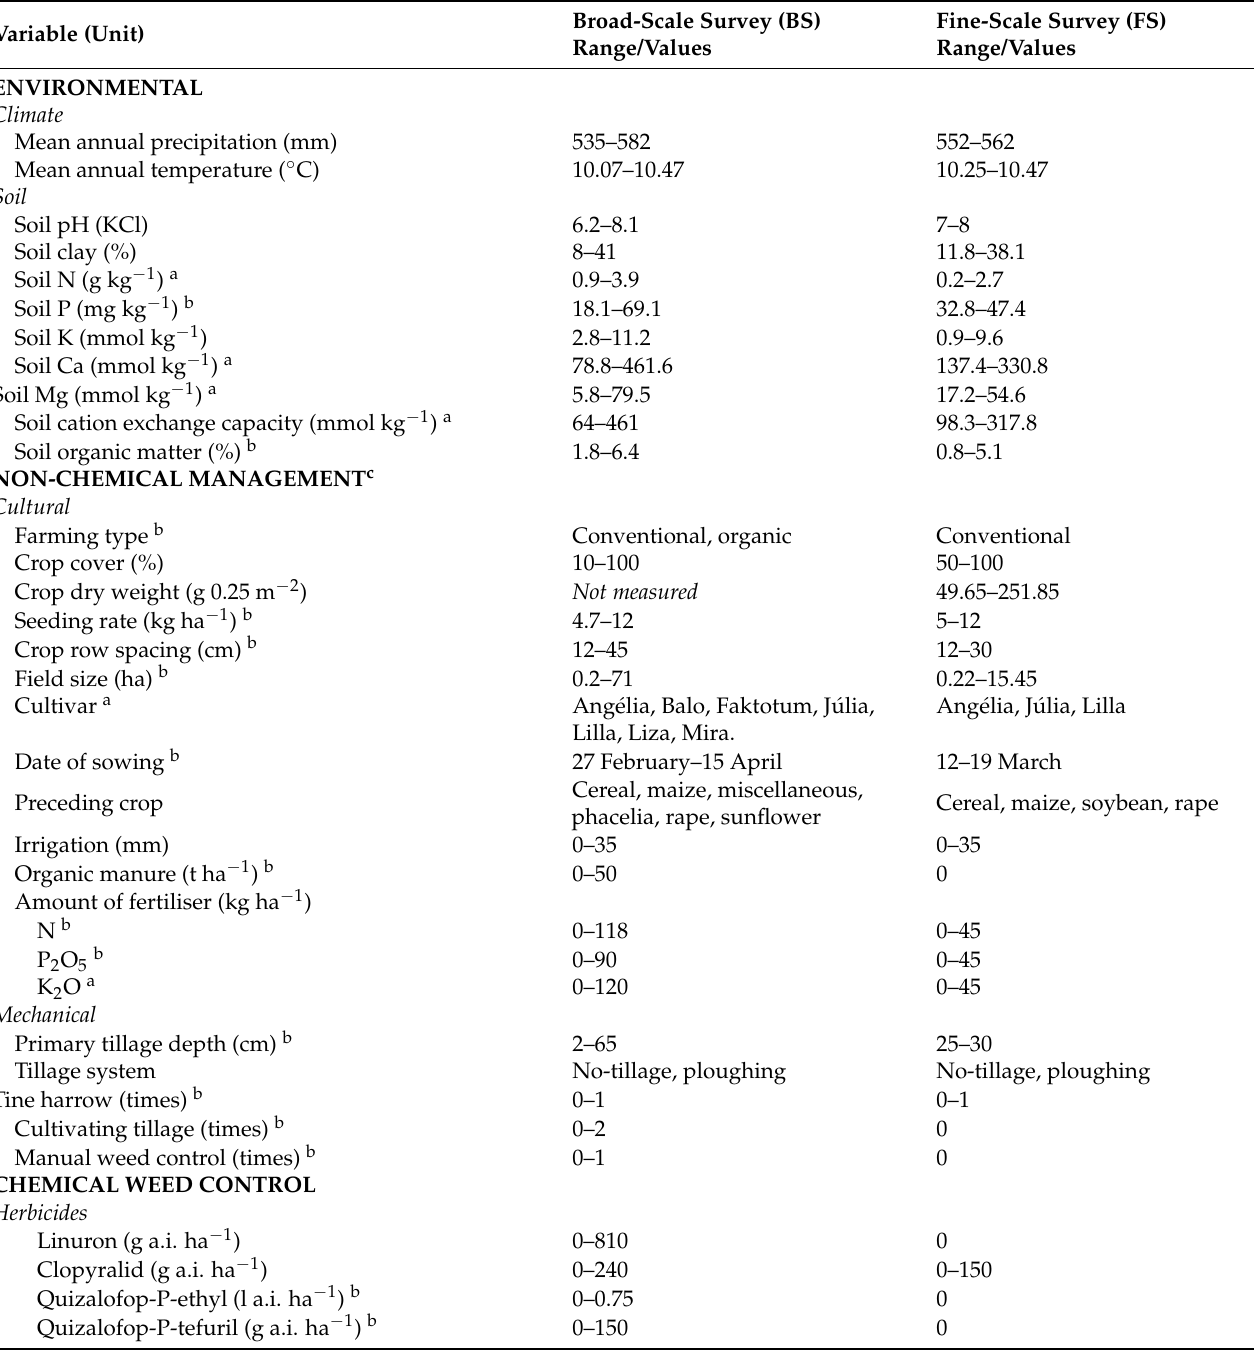
Table 1. Units and ranges of continuous variables and values of categorical variables within the